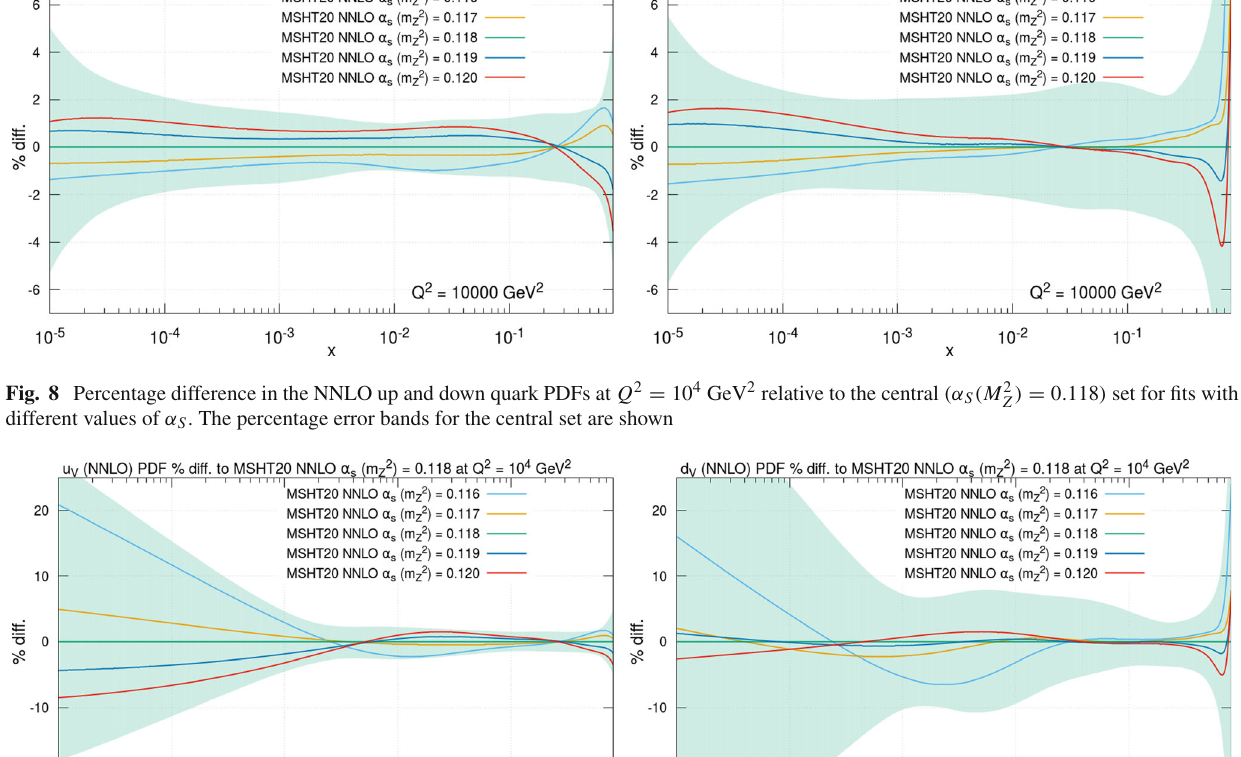
Fig. 7 Percentage difference in the NNLO gluon and strange quark PDFs at Q 2 = 10 4 GeV 2 relative to the central (α S ( M 2 with different values of α S . The percentage error bands for the central set are shown